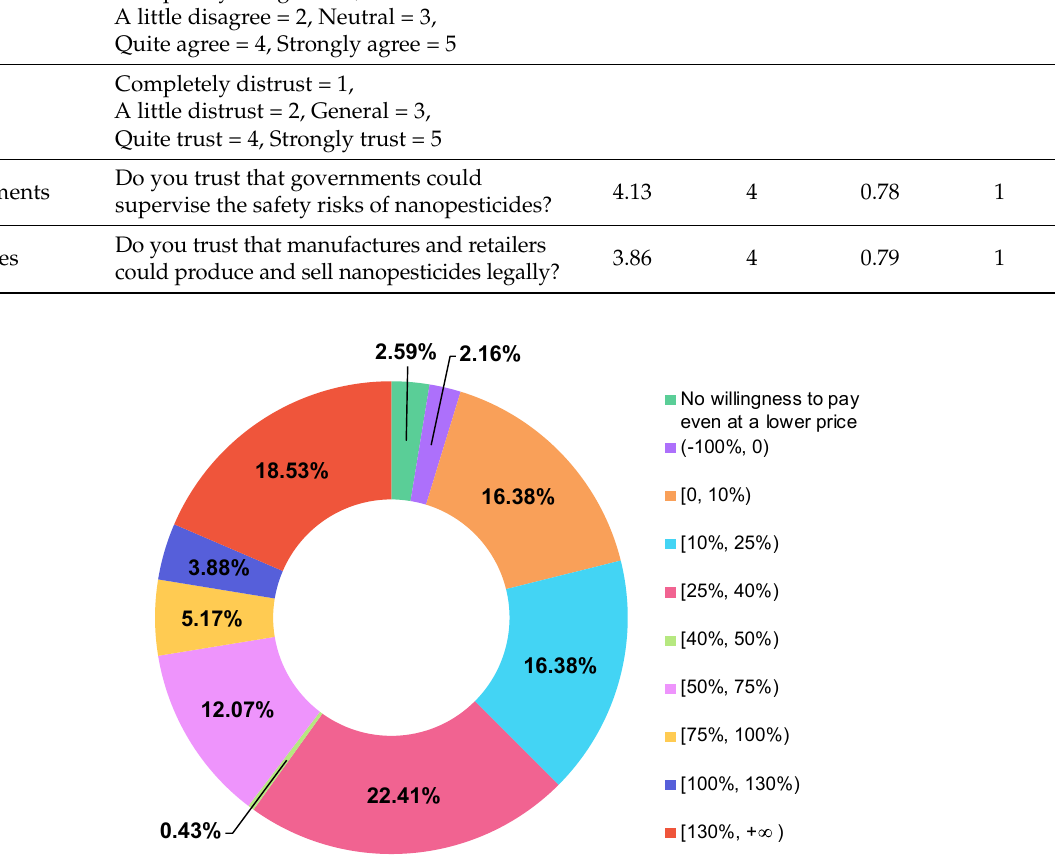
Figure 2. The distribution of the price ranges (% of WTP for nanopesticides over that for conventional pesticides).